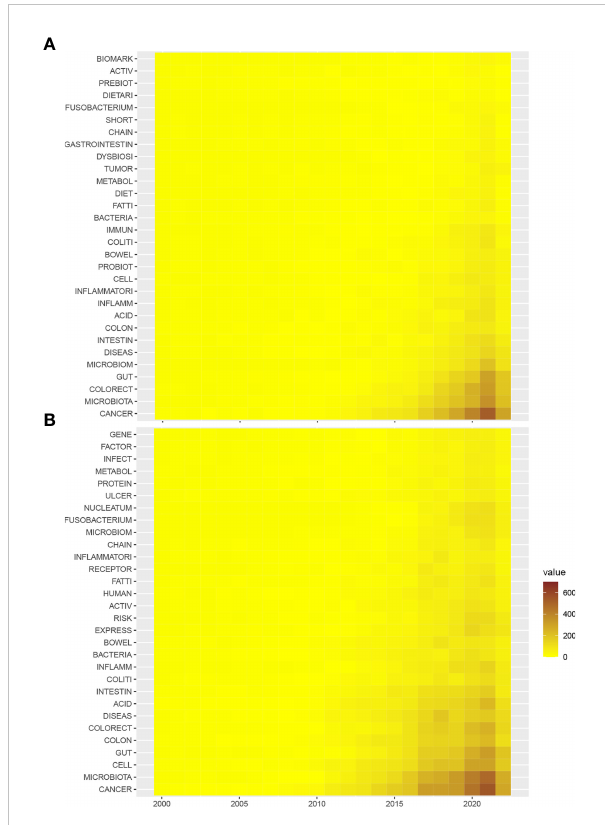
FIGURE 3 Heatmap of the annual occurrence of top keywords derived from the gut microbiome in the CRC. (A) Annual occurrence of author keywords from 2000 to 2022; (B) annual occurrence of keywords plus from 2000 to